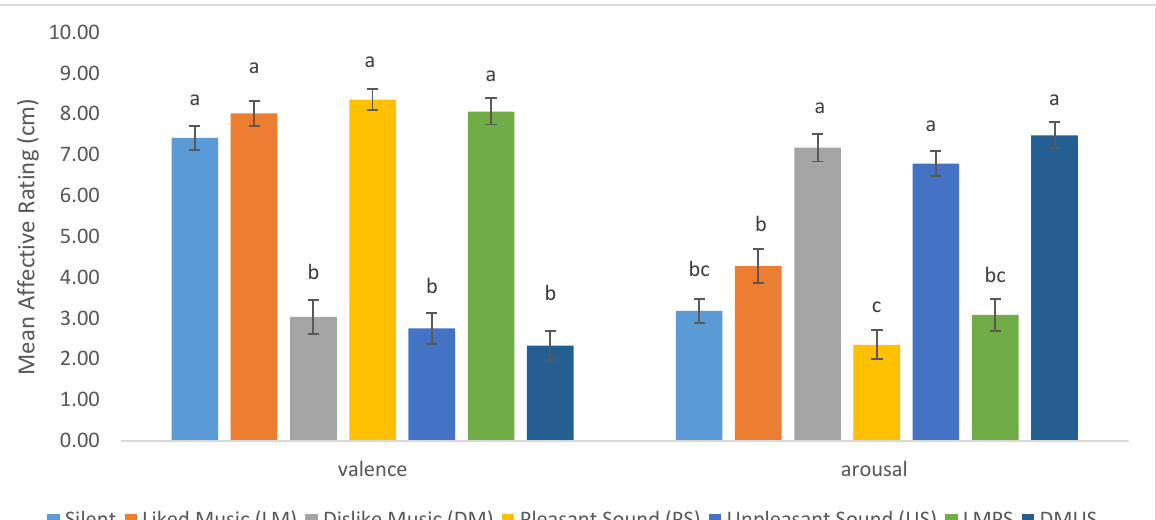
Figure 2. Mean ratings of valence and arousal during consumption of chocolate ice cream under various music and sound conditions. Different letters a , b , c indicates changes in mean affective ratings readings with different superscripts indicating significance ( p < 0.05). Error bar indicates standard error.